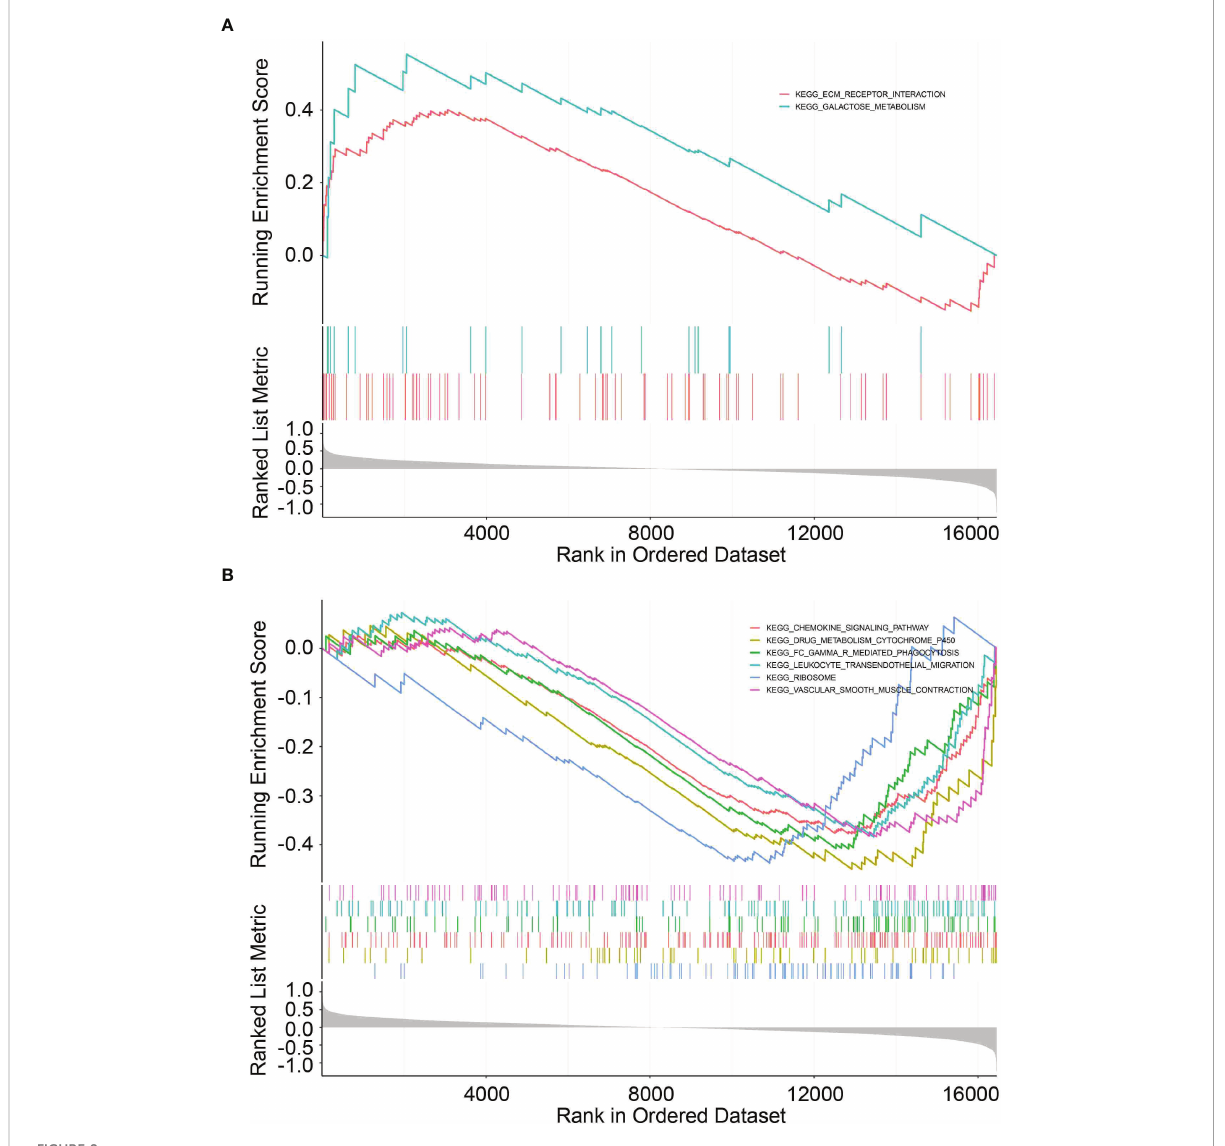
FIGURE 8 GSEA functional pathway analysis. (A, B) Top enriched biological pathways in high- and low-risk group